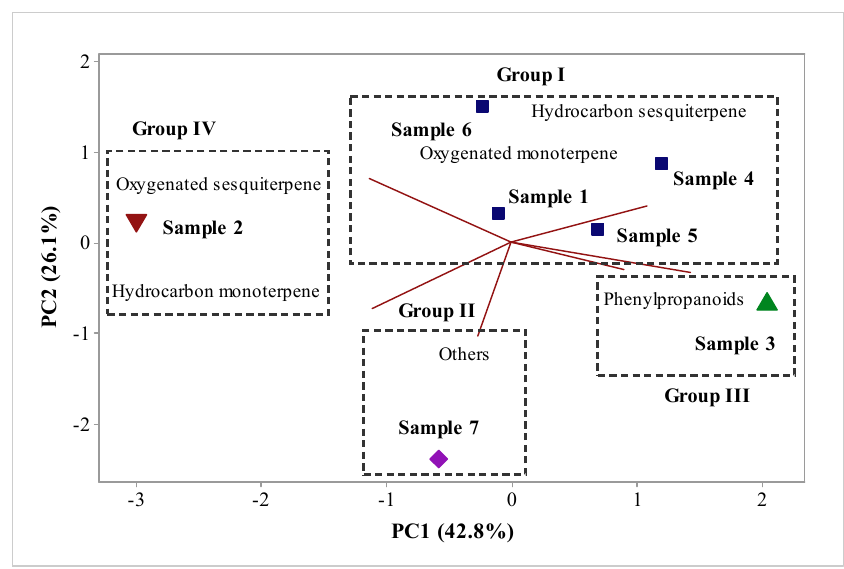
Figure 1. Biplot (principal component analysis) from the analysis of volatile compound classes identified in the aromas of seven samples of bee propolis from Apis mellifera .